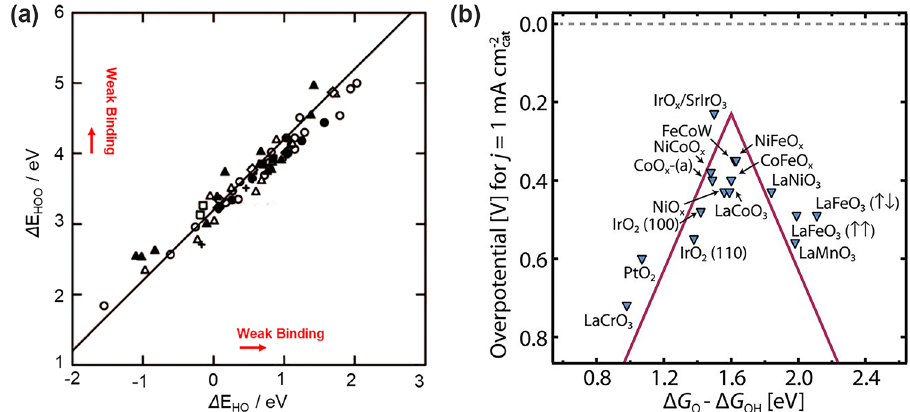
Fig. 3 The adsorption energy scaling relations between oxygen-containing intermediates. a Plot of adsorption energies of HOO* and HO* on metal oxides. Hollow symbols represent the adsorption energy on the clean surfaces: perovskites (circle), rutiles (triangle), Mn x O y (square), anatase (diamond), Co 3 O 4 (+). The solid symbols represent the adsorption energies on high coverage surfaces [37]. Copyright © 2011 Wiley– VCH. b The volcano relationship between Δ G O* –Δ G HO* and OER activity for major oxides [14]. Copyright © 2017 American Association for the Advancement of